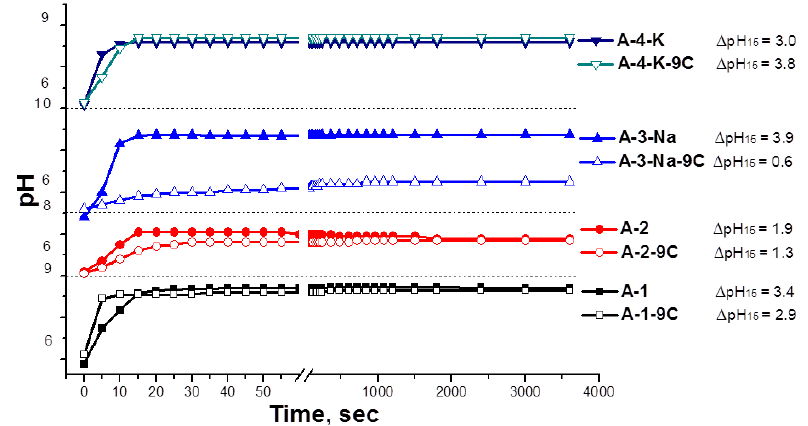
Figure 2. Kinetic curves of the pH of the aqueous suspensions of the initial samples’ dryers and dehumidifiers after nine cycles of adsorption–regeneration, ΔрН 15 : change in pH of the sample for 15 s of contact with